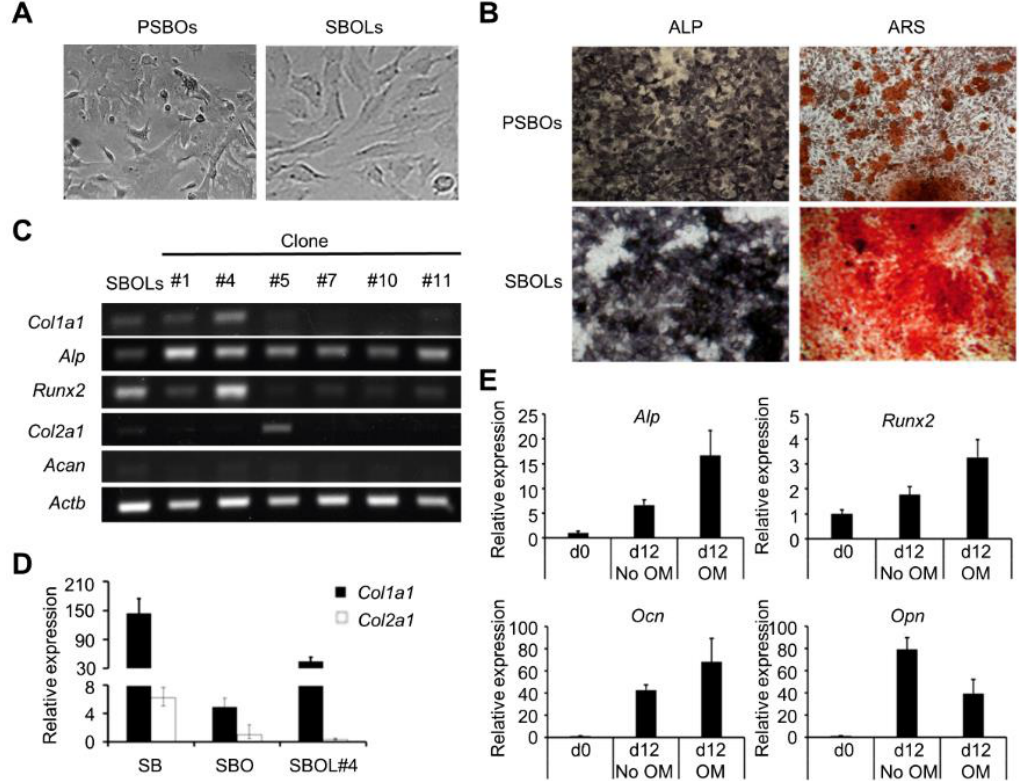
Figure 2. Established SBOLs maintain the primary osteoblastic phenotype. Stable subchondral bone osteoblasts (SBOLs) were selected in the presence of 10 µ g/mL hygromycin B following immortal- ization of primary SBO (PSBO) cells by co-transfection with SV40 T Ag and piggyBac transposase expression vector. For the mineralization assay, cells were grown for 12 d in the presence (+) or absence (−) of the osteogenic medium (OM). ( A ) Light microscopy of PSBOs and SBOLs. Magnifica- tion: 100×. ( B ) Alkaline phosphatase (ALP) and Alizarin Red S (ARS) staining of PSBOs and SBOLs cultured for 7 and 12 d, respectively. Magnification: 40×. ( C ) PCR analysis of gene expression in SBOL subclones. ( D ) Levels of Col1a1 and Col2a1 expression in SB, PSBOs and SBOL clone #4 by RT-qPCR. ( E ) Measurement of Alp , Runx2 , Ocn , and Opn expression in SBOL clone #4 cultured under osteogenic conditions. Data shown in bar graphs represent mean ± SD ( n =